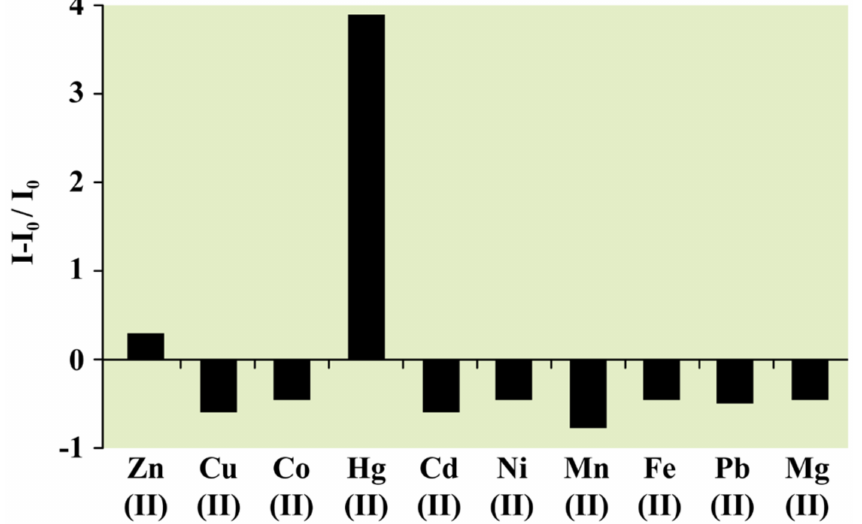
Figure 6. Change in fluorescence ratio of ligand 1 upon addition of 15 equivalents of cations at 336 nm. This red shift was caused due to the stabilization of the fluorophore in its excited state (re-drawn from